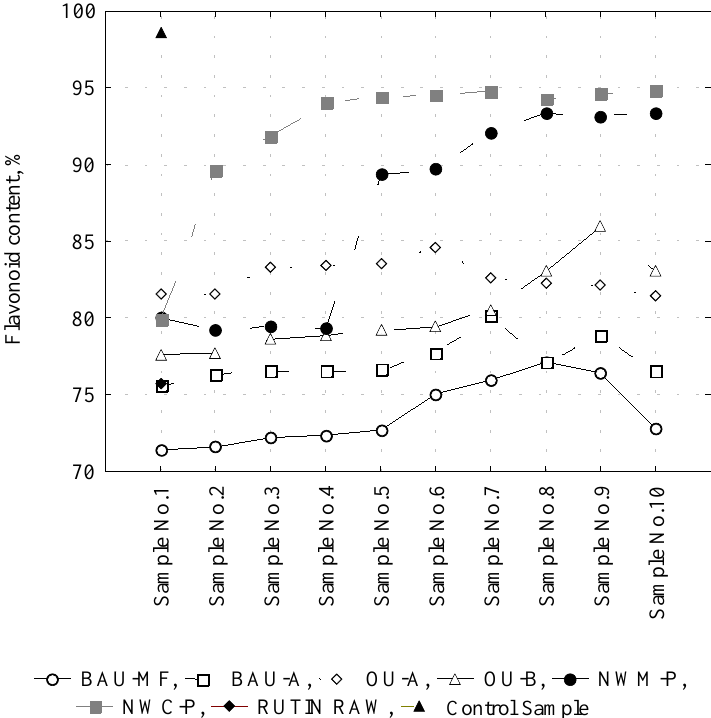
Fig. 4. Dependence of flavonoid amount content in rutin samples on carbon